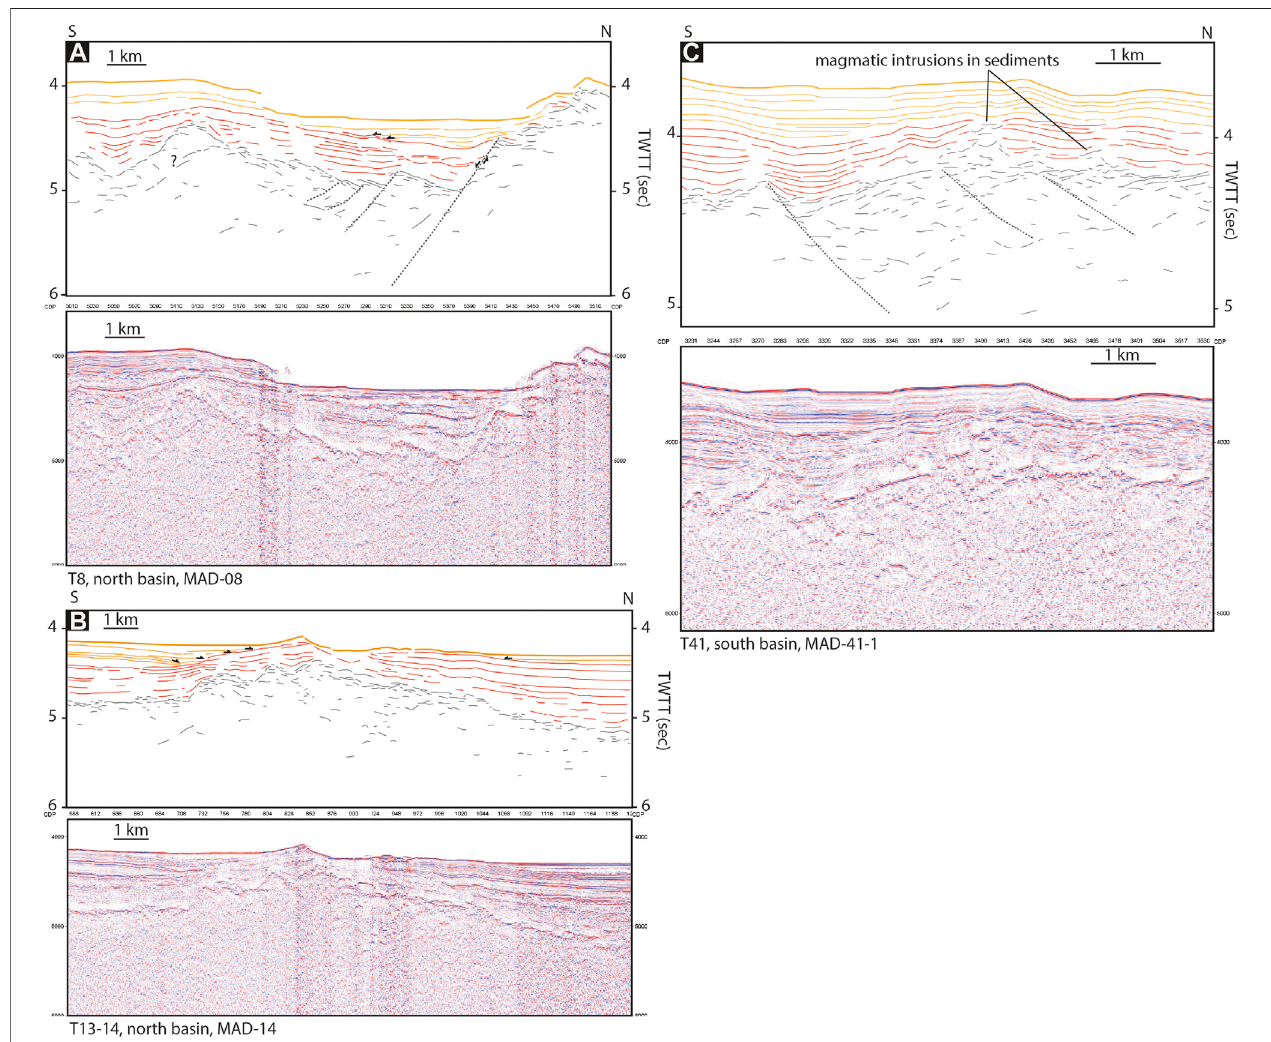
FIGURE 8 | (A) and (B) Examples of sedimentary unconformities in the old oceanic domain suggesting vertical (uplift) movements of the basement after or during the deposition of the red unit. (C) Example of intrusions into the sediments in the old oceanic domain. The top basement/sediments interface is not clear in such areas. Location of the close-up views is shown in Figure 6